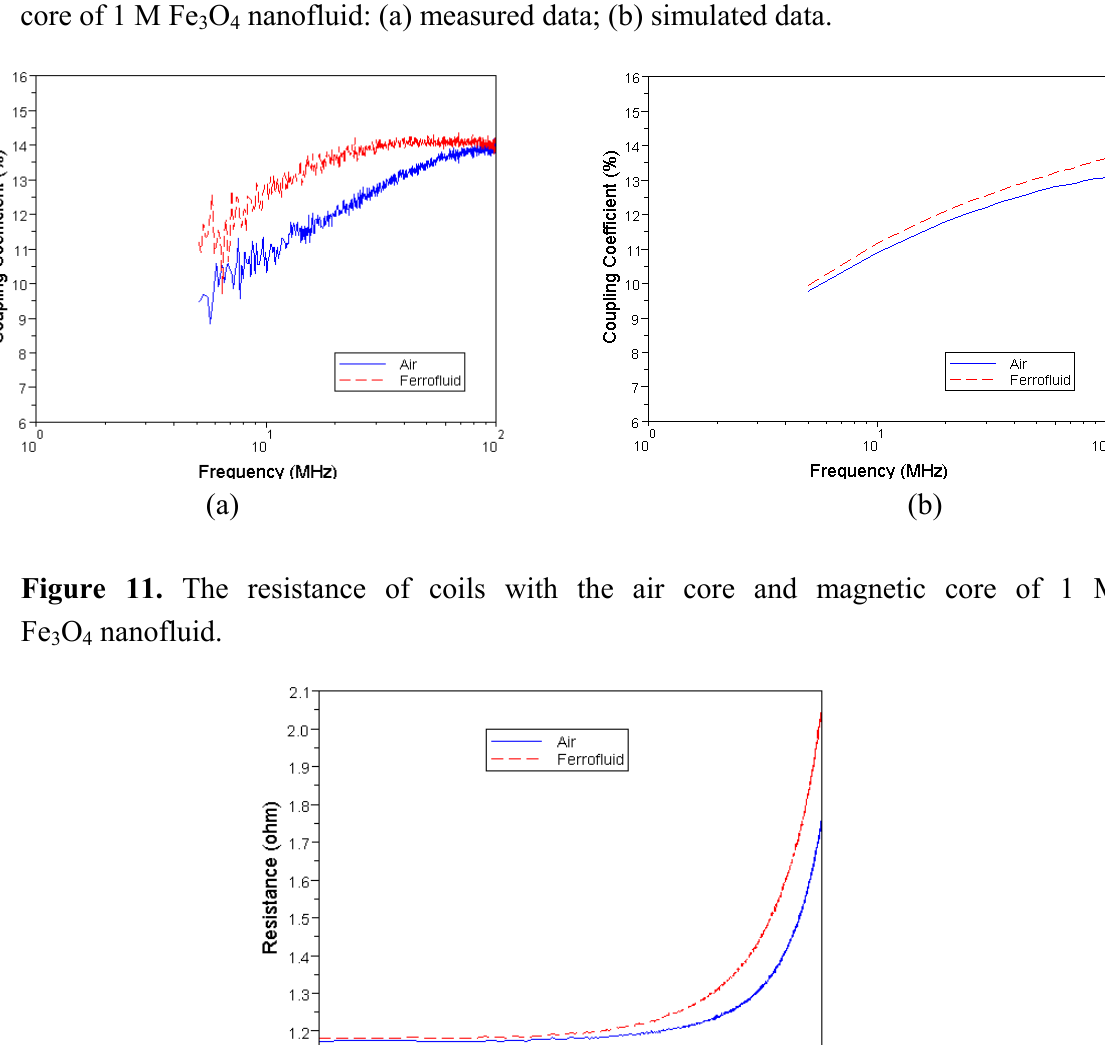
Figure 10. The coupling coefficient of MEMS transformers with the air core and magnetic